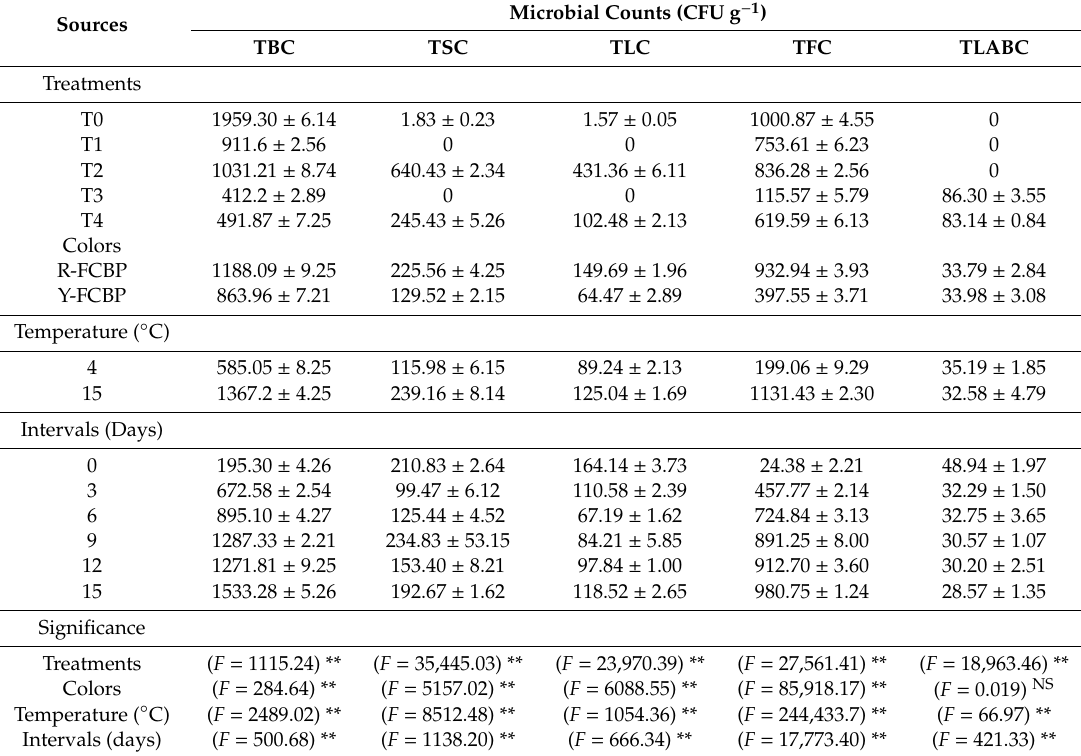
Table 1. Determination of microbial population changes in red (R) and yellow (Y) fresh-cut bell pepper (FCBP) treated or untreated with L. rhamnosus GG and biochemical agents at di ff erent time intervals (days) and preserved in two di ff erent temperatures (4 and 15 ◦ C). The results presented the estimated marginal means ± standard error (SE). ** Significant ( p < 0.01); NS: not significant, TBC: total bacteria count, TSC: total Salmonella count, TLC: total Listeria count, TFC: total fungal count, TLABC: total lactic acid bacterial count, F = variation between sample means / variation within the